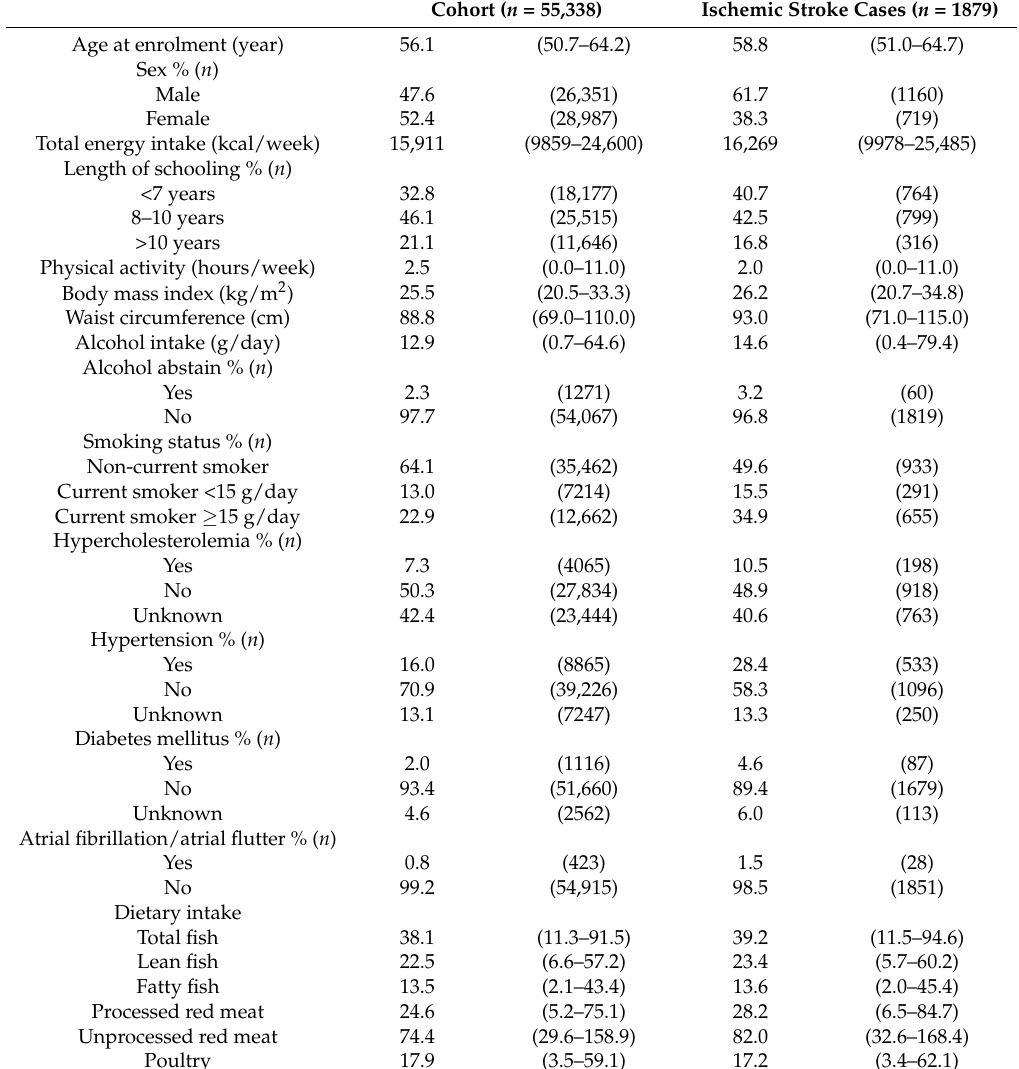
Table 1. Baseline characteristics of the cohort and ischemic stroke